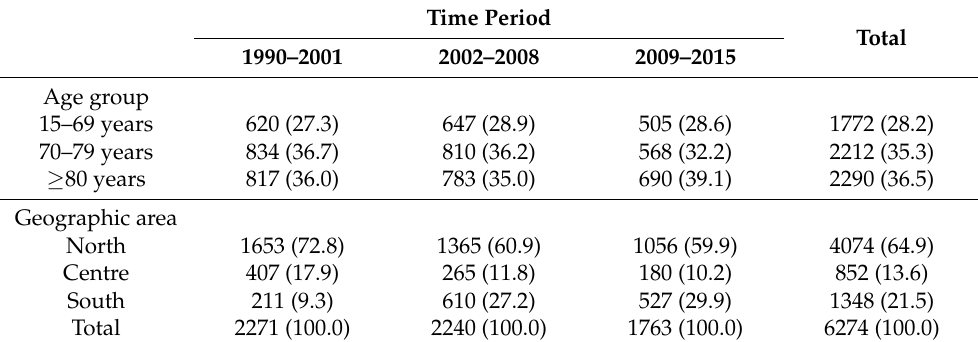
Table 1. Number of patients registered with vulvar squamous cell carcinoma by age group at diagnosis, geographic area, and time period. Italy, 1990–2015 (total resident female population 15,358,161 in